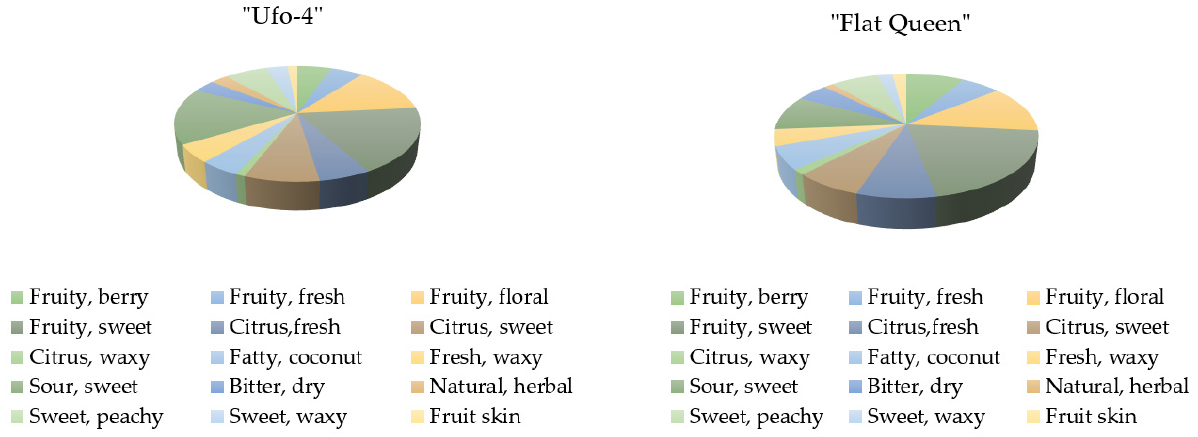
Figure 3. Flavor component distribution (%) in flat peach varieties.